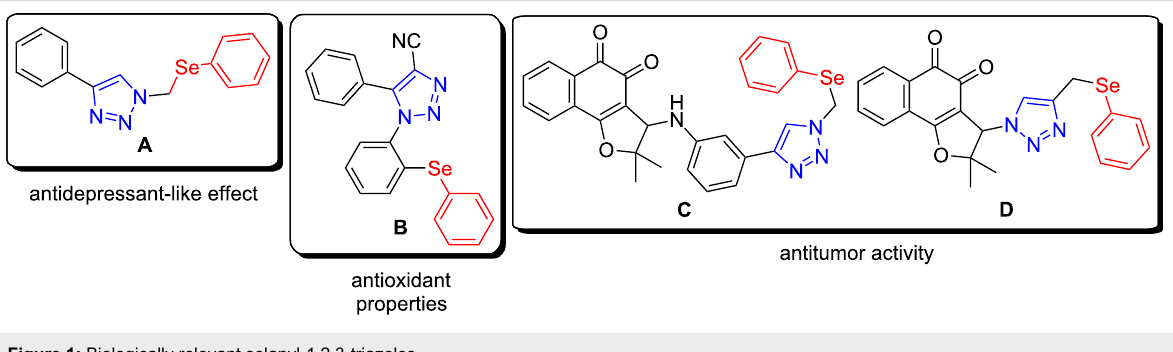
Figure 1: Biologically relevant